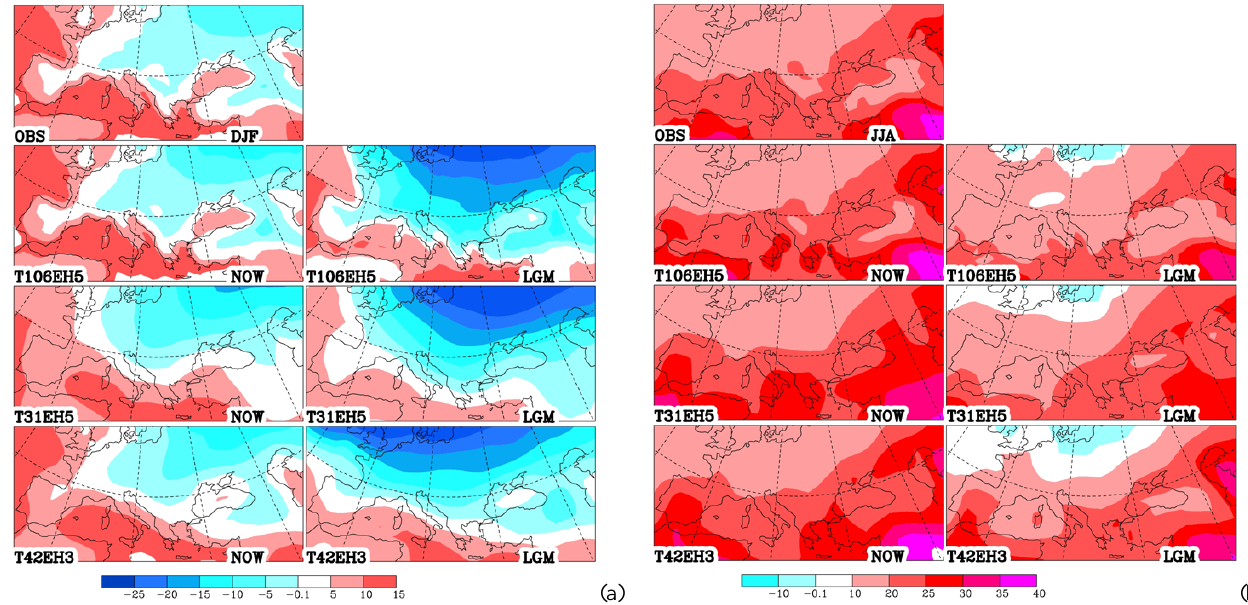
Fig. 2. 2m temperatures for the LGM and NOW as simulated, OBS is the present as analyzed by ERA40 (Uppala et al., 2005), (a) for winter, contours every 5 ◦ C, down to − 25 ◦ C, (b) for summer, contours at − 10, − 0.1, 10, 20, 25, 30, 35 ◦